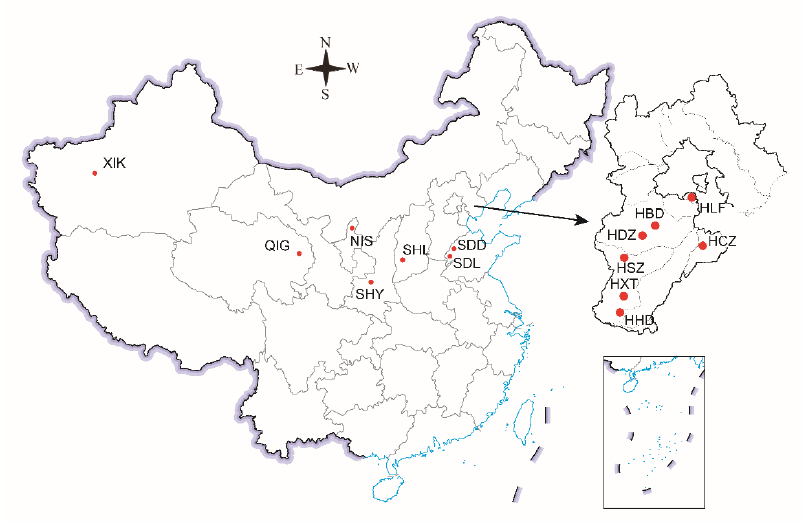
Figure 1. Metopolophium dirhodum sample collection regions in Northern China. Table 1. Information regarding the collected Metopolophium dirhodum field populations.